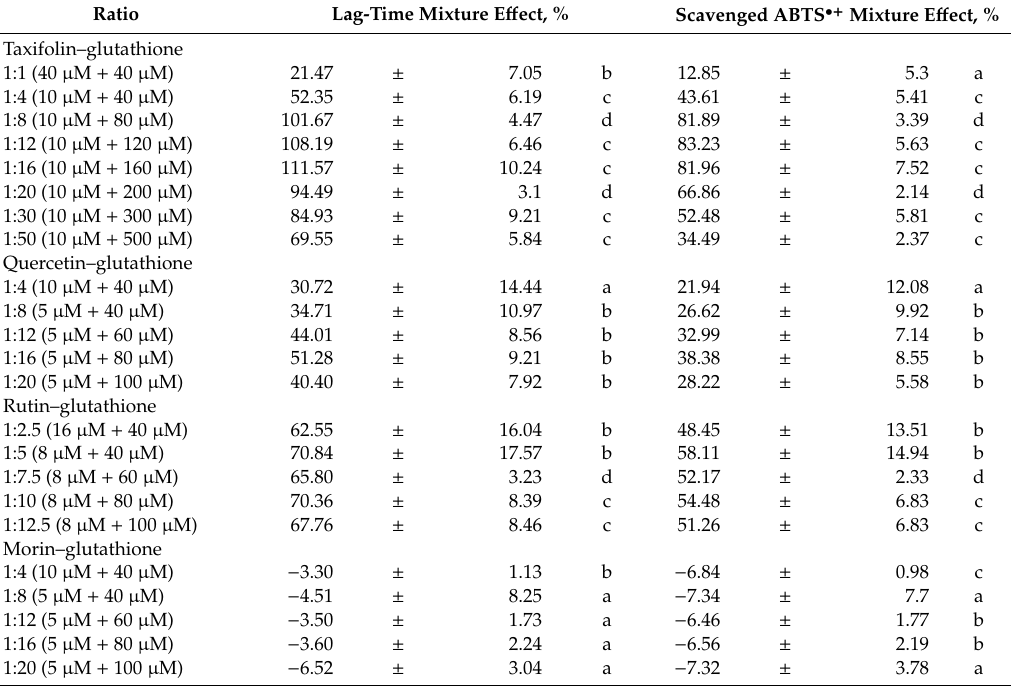
Table 3. Mixture e ff ects of flavonoid–glutathione combinations in the lag-time assay. Ratio Lag-Time Mixture E ff ect,